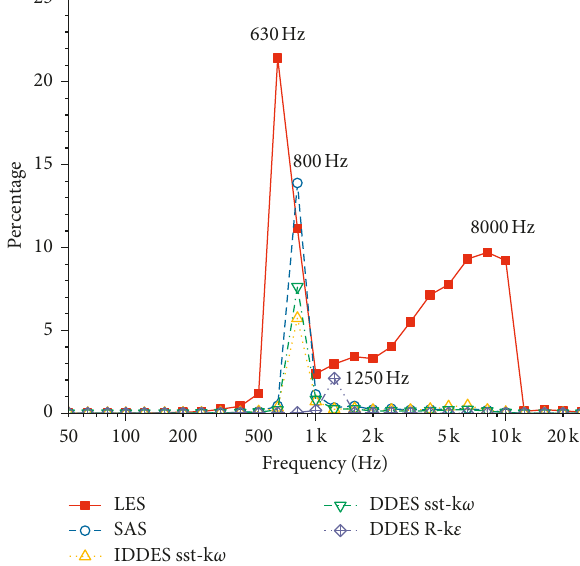
Figure 7: Frequency spectrum curves of W models.